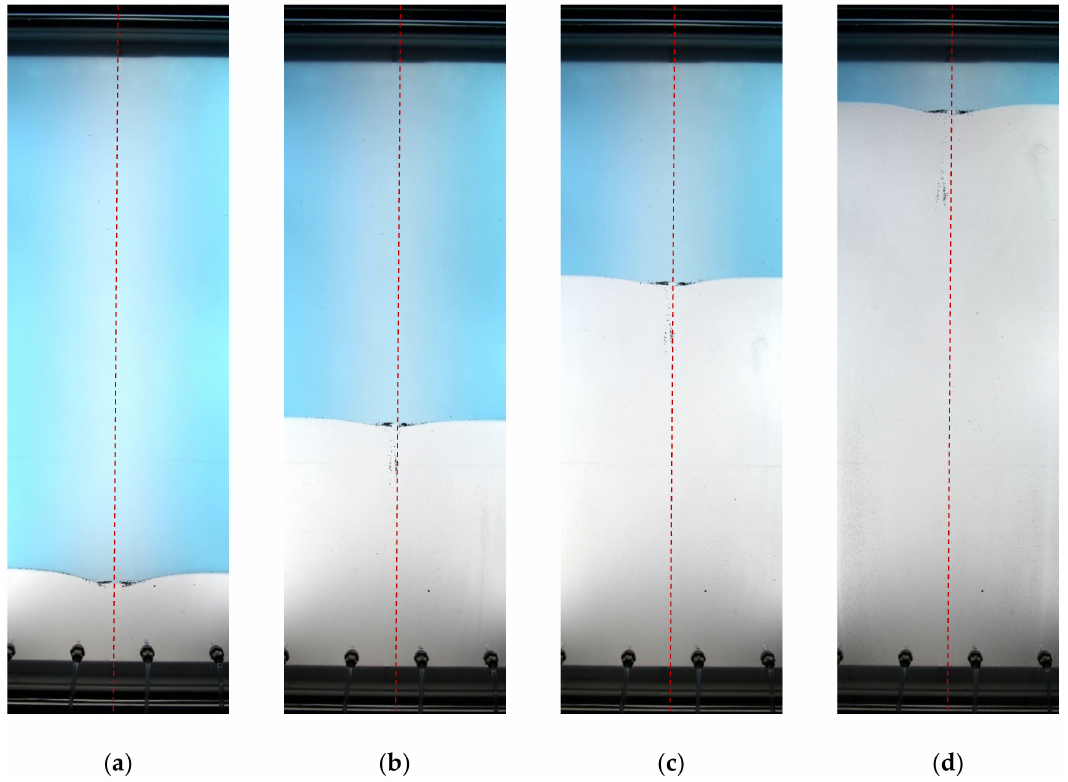
Figure 7. Snapshots of displacement flow in test no. 3: ( a ) t = 0 s; ( b ) t = 6 s; ( c ) t = 11 s; ( d ) t = 17 s.